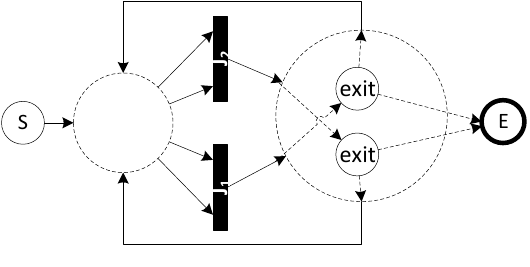
Figure 11. Abstract illustration of two join nodes that may prevent the deadlock detection due to deadlock-free